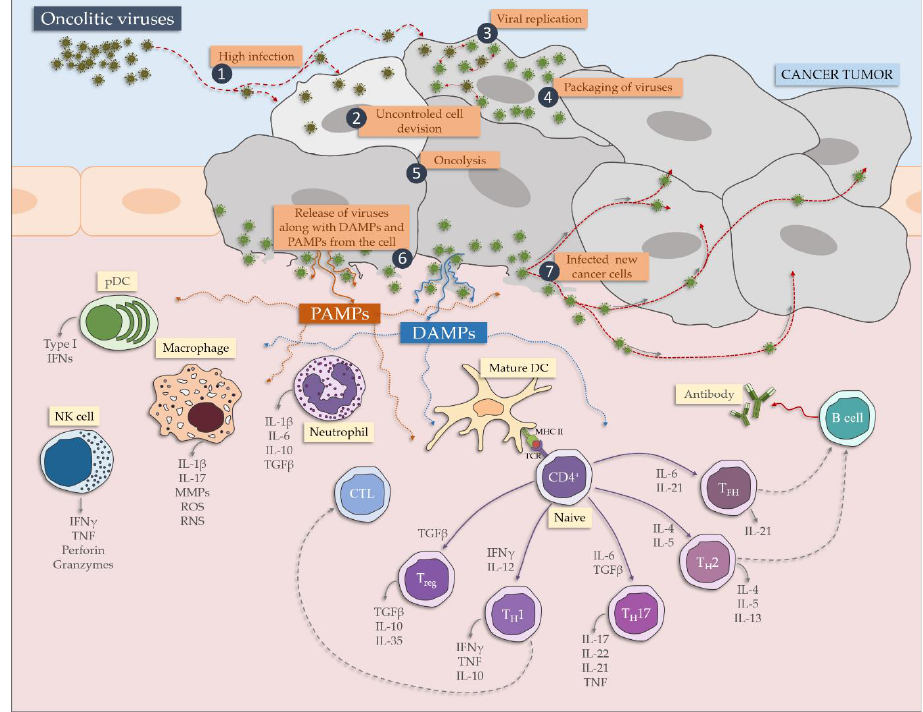
Figure 2. The impact on oncolytic viruses on the immune system.